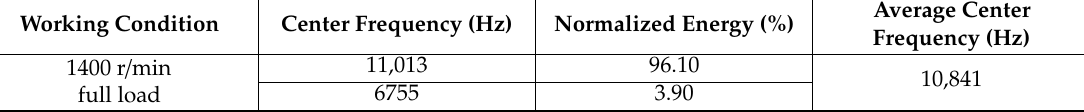
Table 4. Evaluation indexes of pressure oscillation components of 1400 r / min full load condition. Working